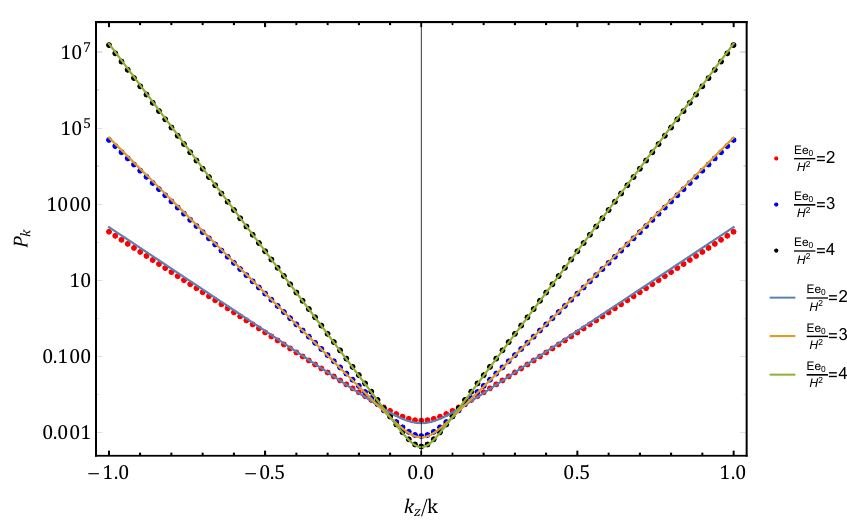
Figure 4 . We here make a comparison on the analytical (line plot) and numerical (dotted plot) results for di(cid:11)erent electric (cid:12)eld strength. At di(cid:11)erent electric (cid:12)eld strength, the power spectrum has di(cid:11)erent angular dependence. We set the mass of massive (cid:12)eld to be 3 H= 2. When the orientation is aligned to the orientation of the (cid:12)eld, the power spectrum is much larger. If the orientation is perpendicular to the orientation of the (cid:12)eld, although the electric (cid:12)eld is strong, Schwinger e(cid:11)ect is weak and the e(cid:11)ective mass is large enough to suppress the power spectrum, hence, the power spectrum can be small with strong electric (cid:12)eld strength. At the orientation parallel to the (cid:12)eld’s orientation, the Schwinger e(cid:11)ect is strong enough to get a large power spectrum.